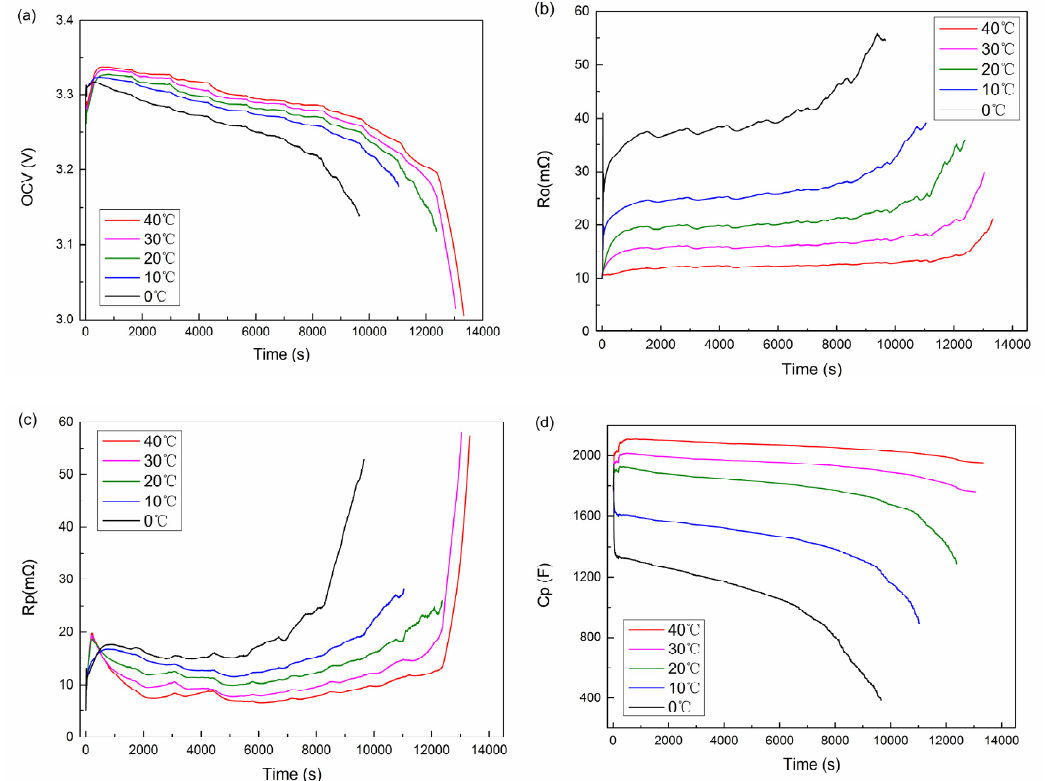
Figure 17. Online parameter estimation results in the FUDS test from 0 °C–40 °C: ( a ) OCV; ( b ) R O ; ( c ) R P ; and ( d ) C P